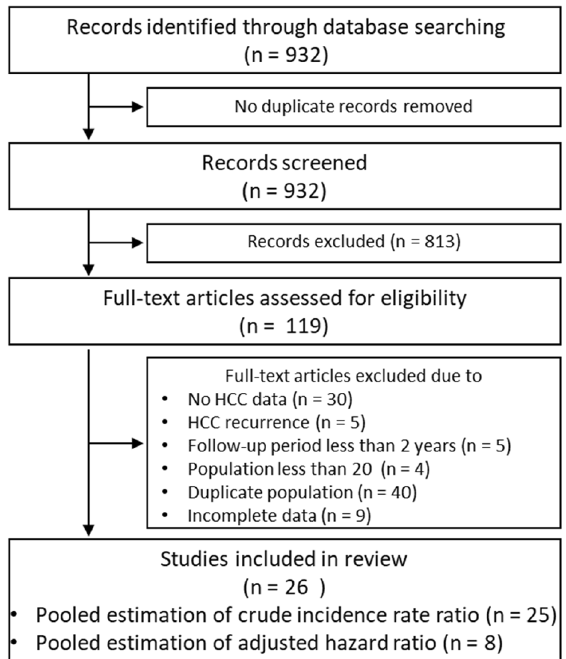
Figure 1. Flow diagram of study search and selection process. HCC hepatocellular